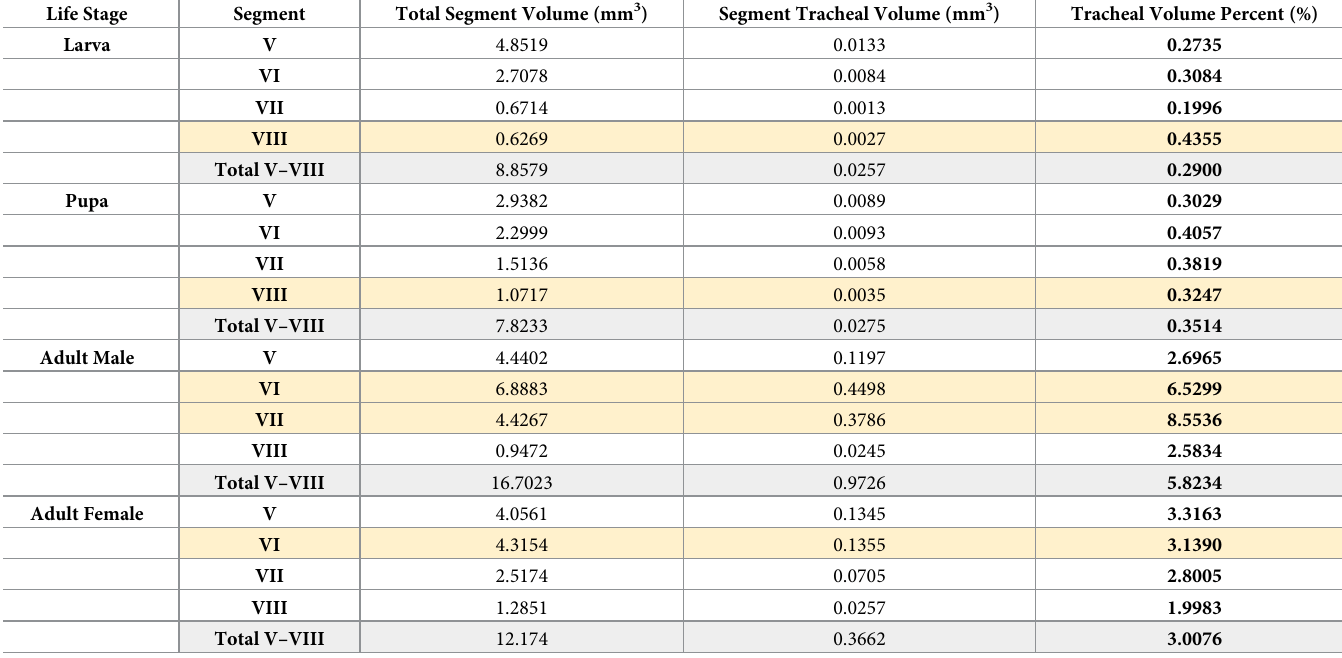
Table 3. Volumetric measurements by segment in larva (last instar), pupa (3–4 days old), adult male, and adult female Photinus pyralis .